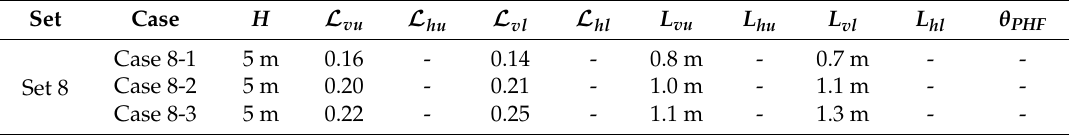
Figure 8. Evaluated PHF trajectories in Set 8 in Table 11 (the legends in ( a – c ) show the σ 3 distributions): ( a ) Evaluated PHF trajectory in Case 8-1; ( b ) Evaluated PHF trajectory in Case 8-2; ( c ) Evaluated PHF trajectory in Case 8-3. Table 13. Field scale PHF behaviors in Set 8 evaluated from laboratory scale numerical